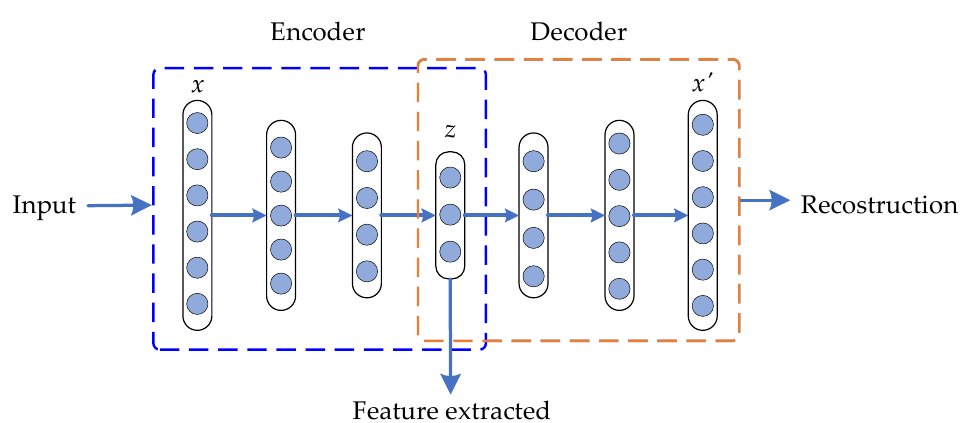
Figure 2. Graphical representation of a stacked AE-based deep neural network structure.